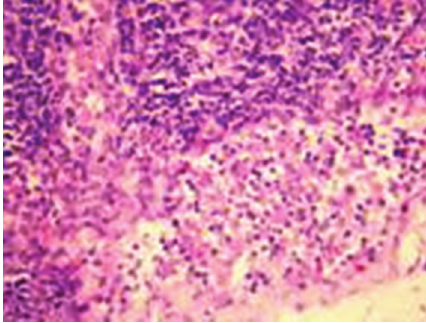
Figure 1: Model control group: 12 hours in SAP rat focal necrosis of germinal center of lymph node, HE × 400.